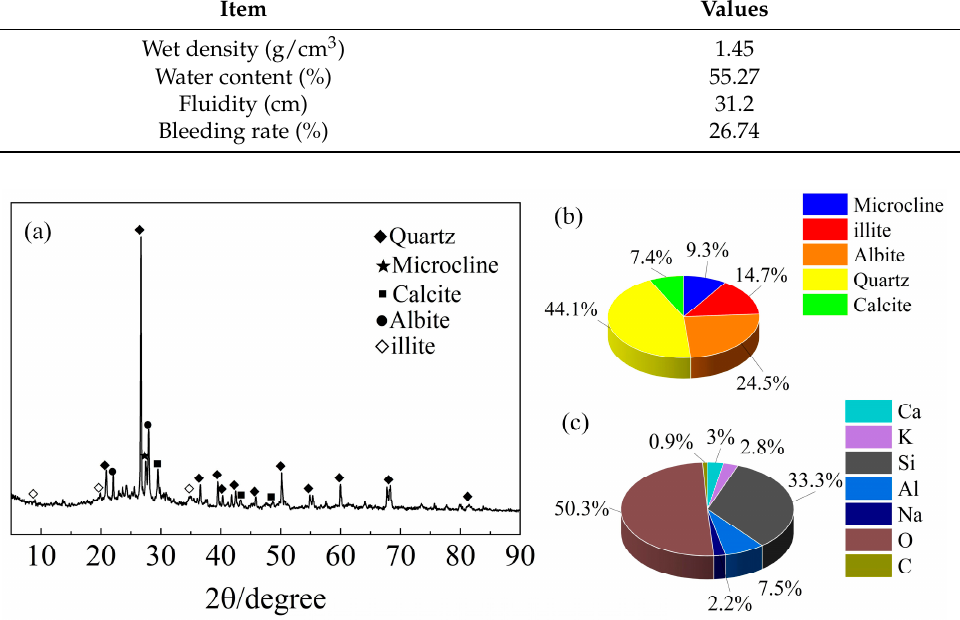
Figure 2. XRD and XRF analyses of DWS. ( a ) XRD spectra. ( b ) The mass fractions of ingredients. ( c ) The mass fractions of elements (Wt%).